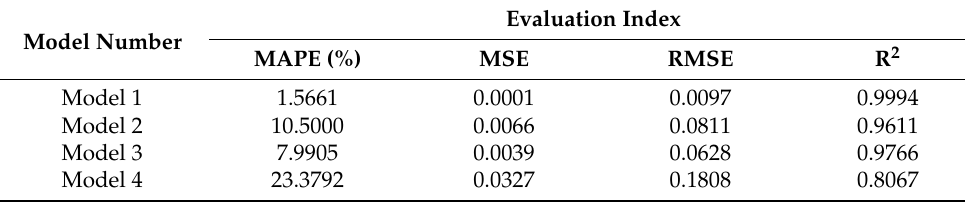
Figure 9. Periodic displacement prediction results of different training sets: ( a ) prediction results of Model 1; ( b ) prediction results of Model 2; ( c ) prediction results of Model 3; ( d ) prediction results of Model 4. Table 4. Evaluation index values of different models of periodic